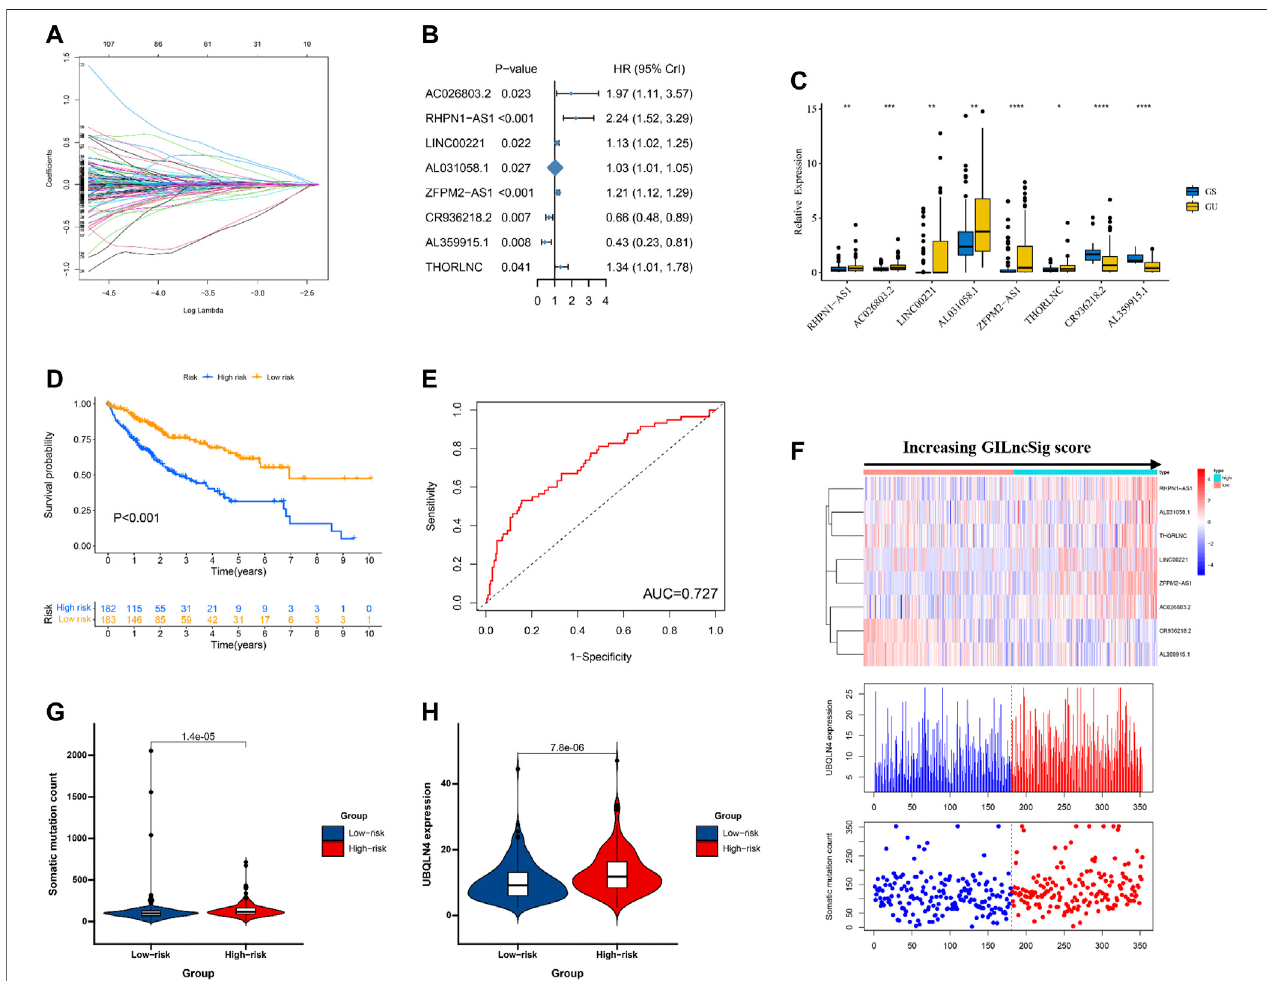
FIGURE3 | Identi fi cation ofthe genomic instability-derived lncRNA signature (GILncSig) for outcome prediction in the TCGA set. (A) The coef fi cients calculated by multivariate Cox regression using LASSO are shown. (B) Forest plots showing the results of the multivariate Cox regression between GILncSig expression and OS. (C) The expression level of 8 GILncs in GS and GU groups. (D) Kaplan – Meier estimates of overall survival of patients with low or high risk predicted by the GILncSig in the TCGA set. Statistical analysis was performed using the log-rank test and univariate Cox analysis. (E) Time-dependent ROC curves analysis of the GILncSig at 1 year (F) LncRNA expression patterns and the distribution of somatic mutation and UBQLN4 expression with increasing GILncSig score. The distribution of somatic cumulative mutations (G) and UBQLN4 expression in the (H) in the high- and low-risk groups for HCC patients. The red represents the high-risk group, and the blue represents the low-risk group. Horizontal lines: median values. Statistical analysis was performed using the Mann – Whitney U test.